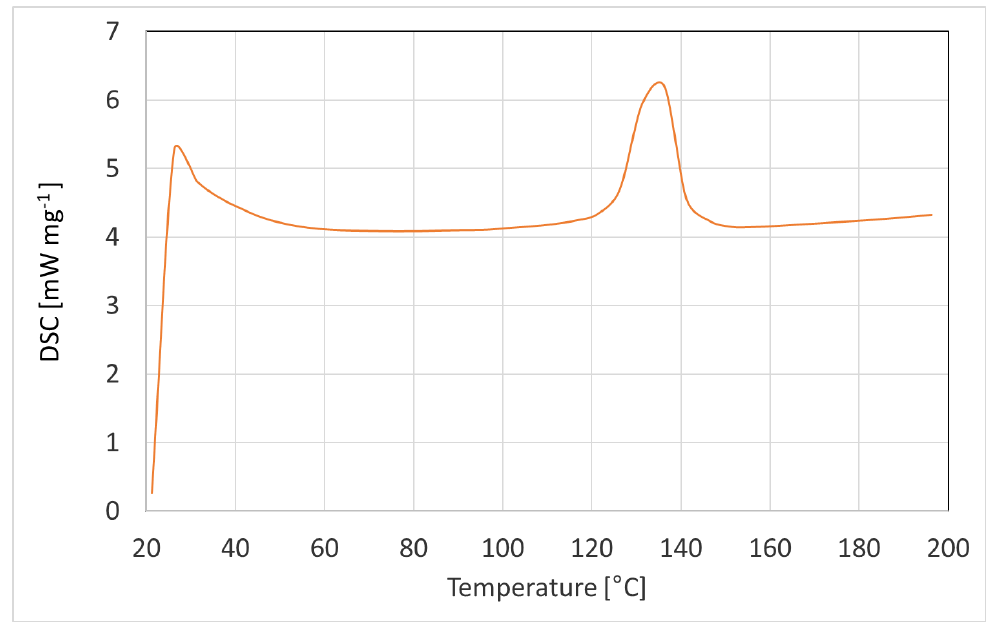
Figure 2. Differential scanning calorimetry (DSC) results for the determination of the glass transition temperature and crystallization.